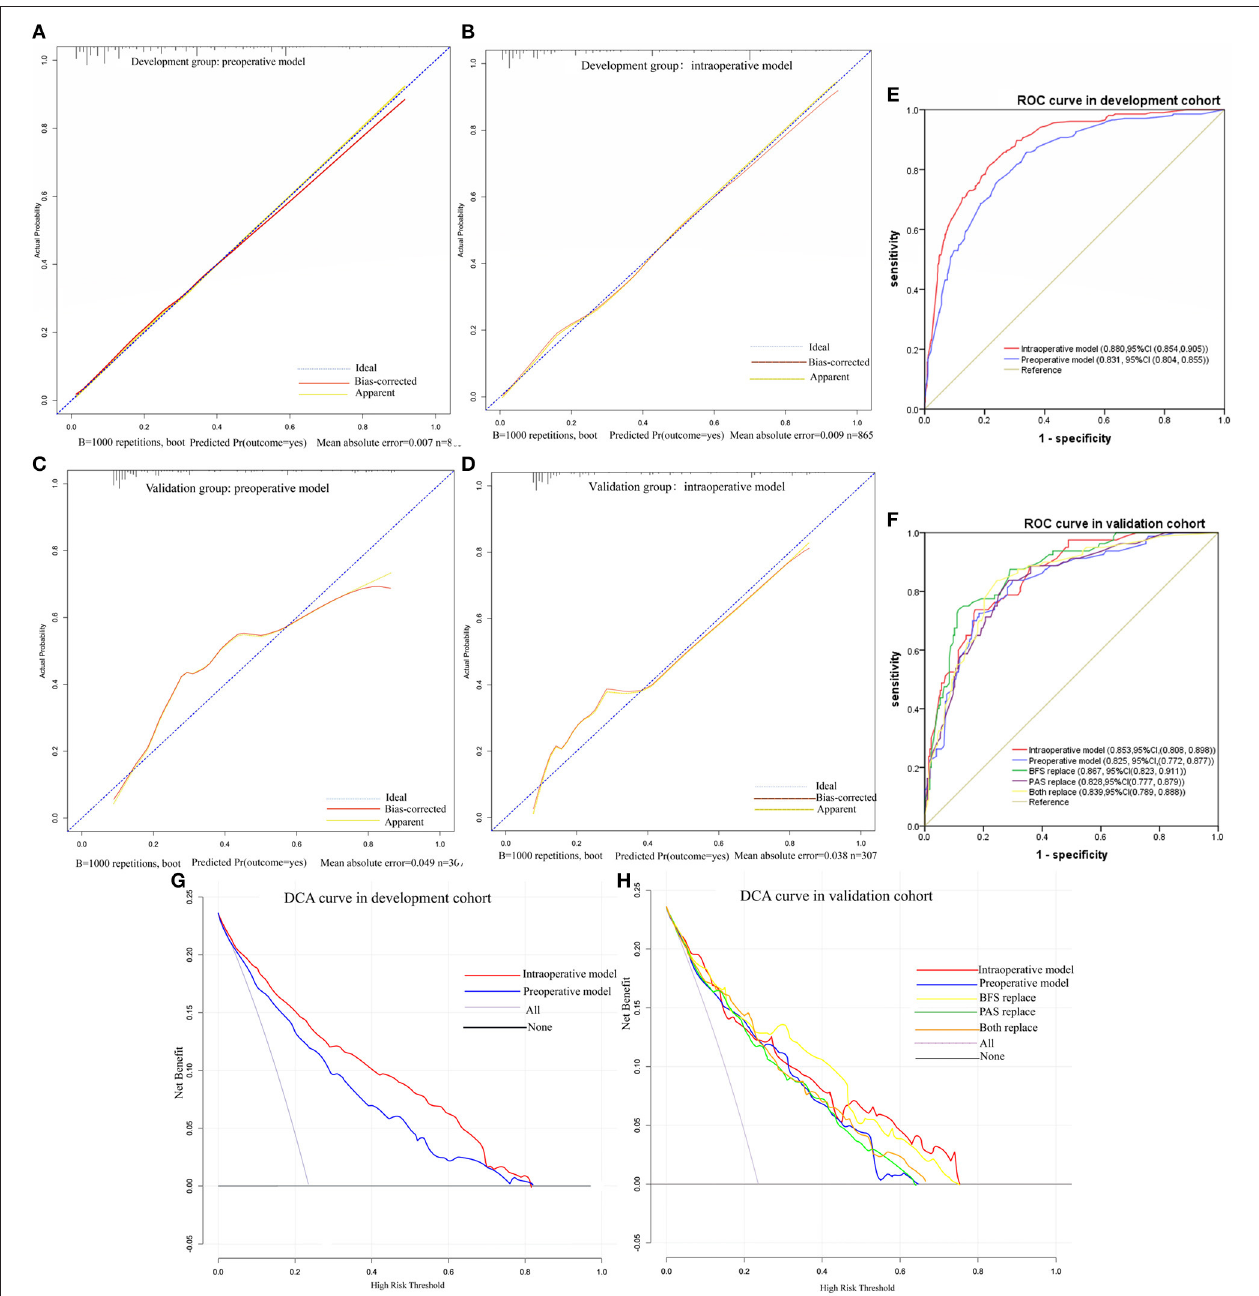
FIGURE 3 | Calibration cures, ROC cures and DCA cures. (A) Calibration cure of preoperative model in development cohort. (B) Calibration cure of intraoperative model in development cohort. (C) Calibration cure of preoperative model in validation cohort. (D) Calibration cure of intraoperative model in validation cohort. (E) ROC curve in development cohort. (F) ROC curve in validation cohort. (G) DCA curve in development cohort. (H) DCA curve in validation